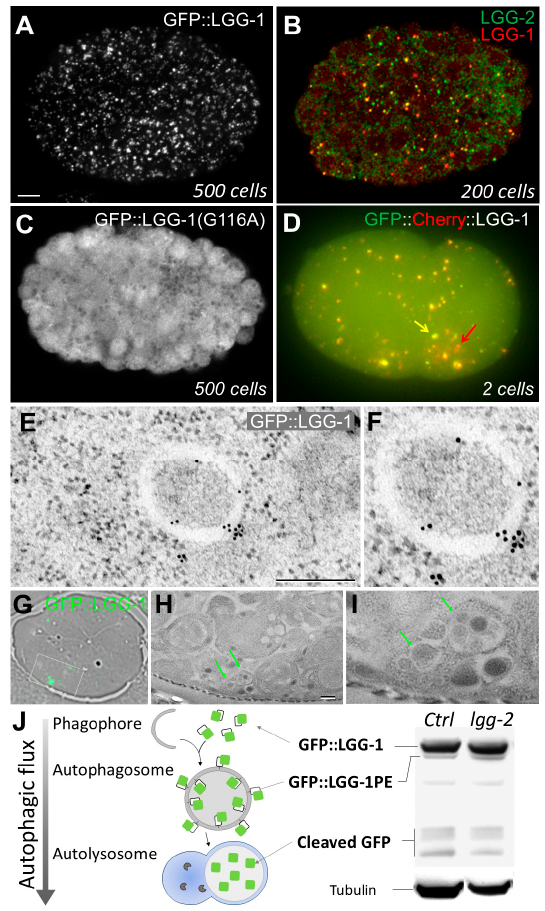
Figure 1. Use of LGG-1 and LGG-2 to monitor autophagy in C. elegans . ( A ) In vivo confocal picture of GFP::LGG-1 in a 500-cell embryo. GFP::LGG-1 puncta correspond to autophagosomes; ( B ) Merge confocal picture of a co-immunostaining of LGG-1 and LGG-2 in 200-cell embryo. Three types of puncta can be distinguished: LGG-1 positive (red), LGG-2 positive (green), and double positive (yellow); ( C ) In vivo confocal picture of GFP::LGG-1(G116A) form in a 500-cell embryo. This non-lipidated form presents a diffuse localization pattern with no puncta; ( D ) Epifluorescence merge picture of the tandem GFP::mCherry::LGG-1 in a two-cell embryo. The yellow arrow indicates an autophagosome (yellow resulting from GFP and mCherry fluorescences), whereas the red arrow shows an autolysosome (only mCherry fluorescence in acidic compartment); ( E , F ) Electron micrographs of GFP::LGG-1 embryos incubated with antibodies coupled to gold beads, revealing autophagosomal structures; ( G – I ) Correlative light and electron microscopy (CLEM) analysis of GFP::LGG-1; ( G ) Merge between bright field and fluorescence images of an ultrathin section of an embryo; ( H , I ) Electron micrographs of the boxed region in G. Green arrows indicate GFP::LGG-1 positive autophagosomes; ( J ) Schematic representation of autophagic flux and Western blot analysis of GFP::LGG-1 using GFP antibodies. The cleaved GFP correspond to a product of degradation in autolysosomes. The relative quantity of GFP::LGG-1 and the phosphatidylethanolamine (PE) conjugated form allows the measurement of the autophagic flux. Tubulin is used for normalization. Scale bar: 5 µm ( A ); 2 µm ( E ); 1 µm ( H ).